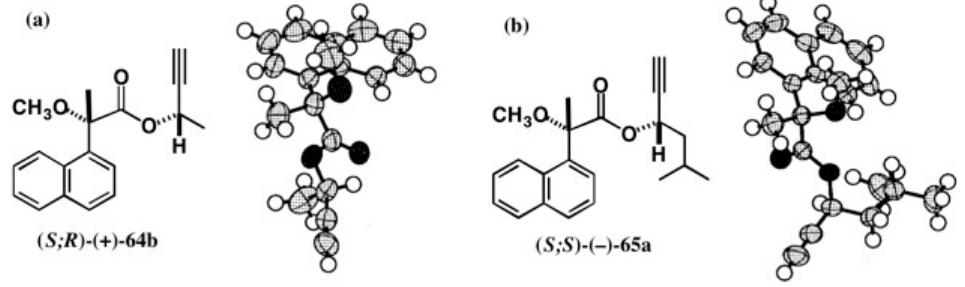
Figure 45. X-ray ORTEP drawings of M α NP esters ( S ; R )-(+)- 64b (a) and ( S ; S )-( − )- 65a (b). Reprinted with permission from [56].